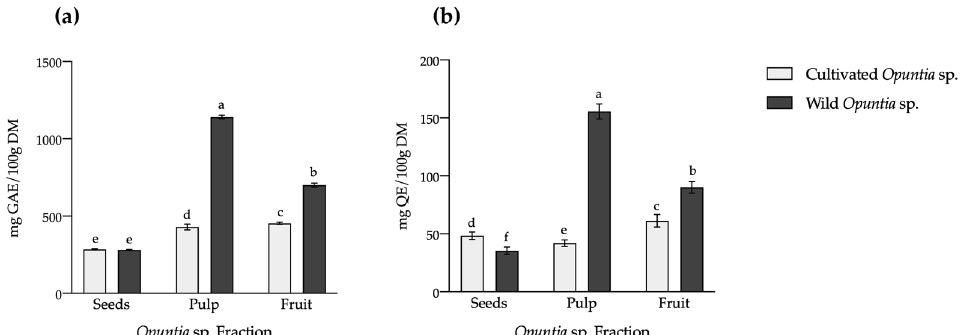
Figure 3. Phytochemical composition of different Opuntia sp. fractions. ( a ) Total Phenolic Content; ( b ) Total Flavonoid Content. Results are expressed as mean ± SD of at least five independent assays. TPC and TFC are expressed as mg of Gallic Acid Equivalents (GAE) and Quercetin Equivalents (QE) per 100 g of dry matter (DM). Significant differences between the samples were designed with different letters from the most significant (letter a) to the lowest significant (letter f) ( p ≤ 0.05, ANOVA). Within the vast group of polyphenols, the flavonoids family represents the most im- portant due to its high antioxidant capacity, which mainly results from the variable num- ber and position of hydroxyl groups in the molecules [49]. The TFC was significantly dif- ferent ( p ≤ 0.05) between the two varieties and their fractions (Figure 3b). As for TPC, the